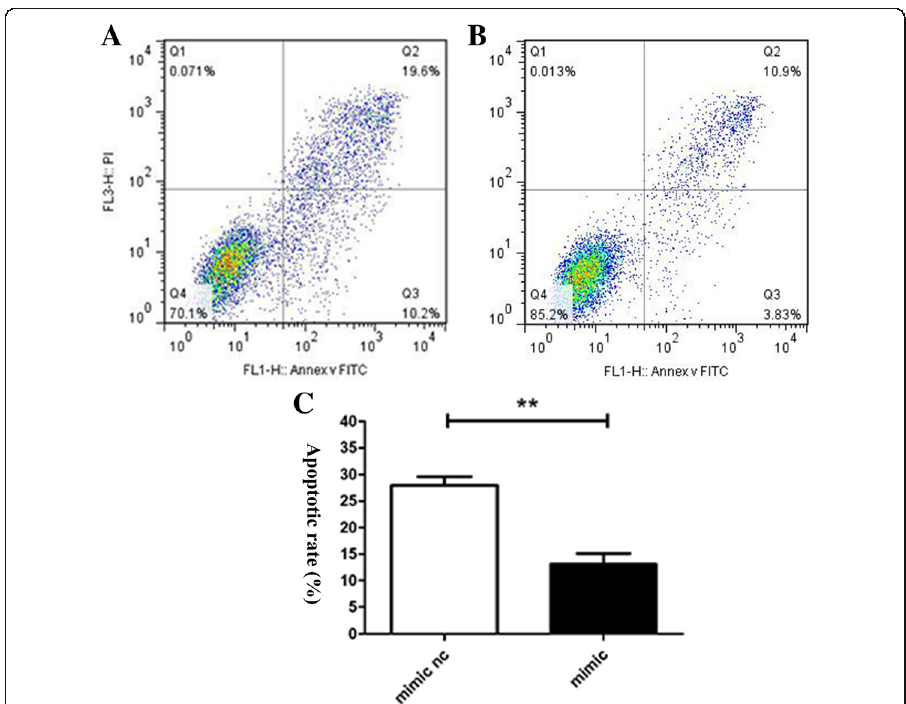
NC group. b – miR-431-5p mimic group. c – Flow cytometry was used to assess the apoptotic rate ( n =